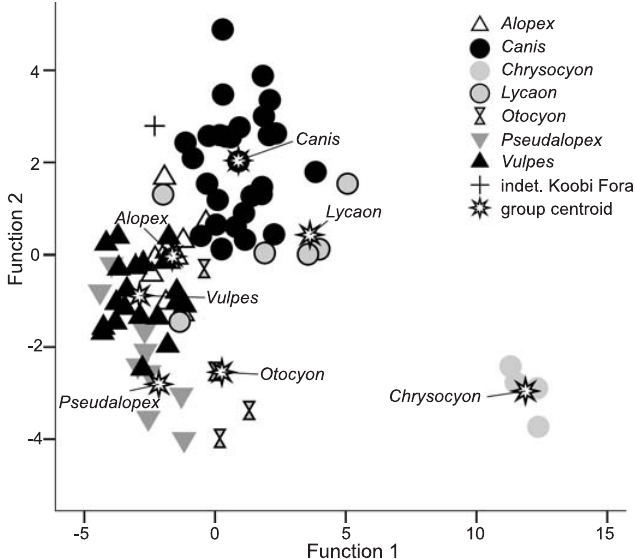
Canidae.Fig. 2. Plot of the first two linear discriminant functions extracted from a combination of radial measurements used to classify genera within